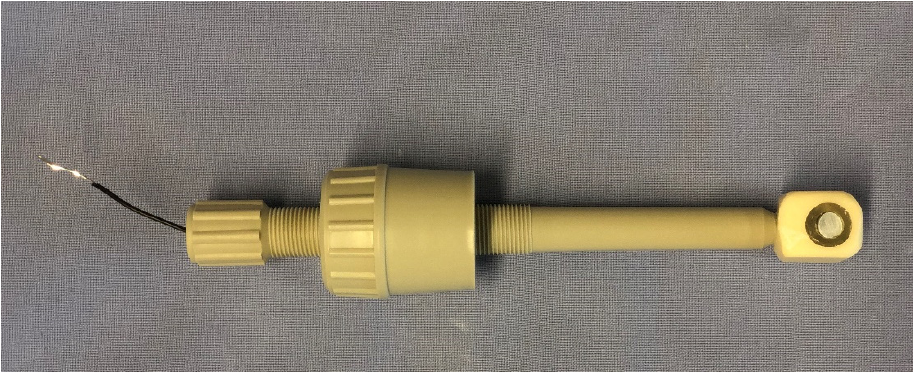
Figure 1. Corrosion sample attached to sample holder.